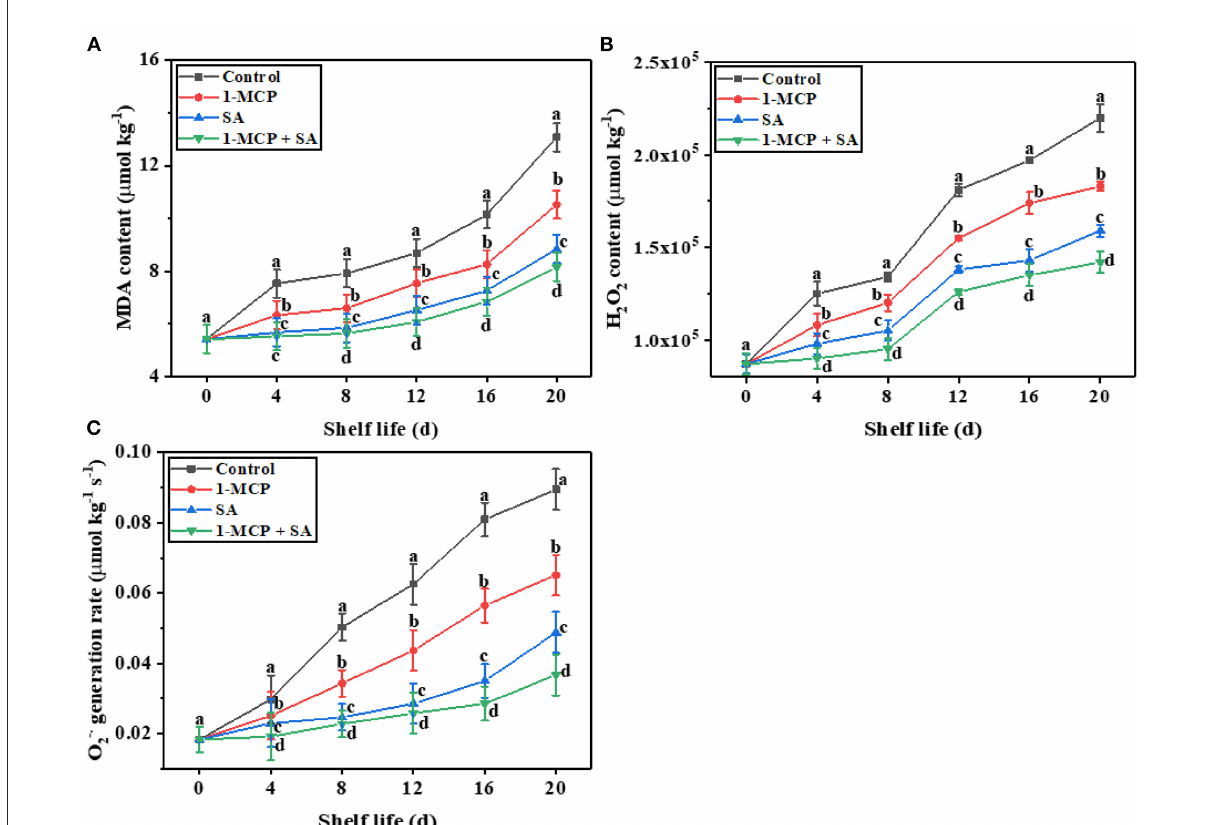
FIGURE4 Effects of 1-methylcyclopropene (1-MCP), salicylic acid (SA), and 1-MCP and MDA content (A) , H 2 O 2 content (B) , and O 2 −· generate rate (C) of winter jujube fruit during shelf life at 4 ± 1 ◦ C for 20 d. MDA, malondialdehyde; H 2 O 2 , hydrogen peroxide; O 2 −· , superoxide anion. The data presented are the mean values of three replicates; vertical bars represent the standard errors of the mean values; values followed by different superscripts (a-d) are significantly different ( P < 0.05) on the same sampling